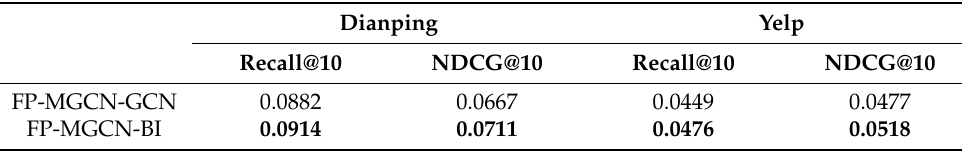
Table 5. Effect of aggregators for representations.